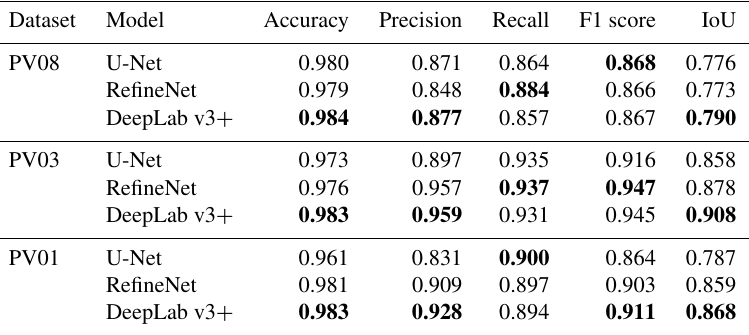
Table 2. Segmentation accuracy in terms of different evaluation indices. The best values are marked in bold.